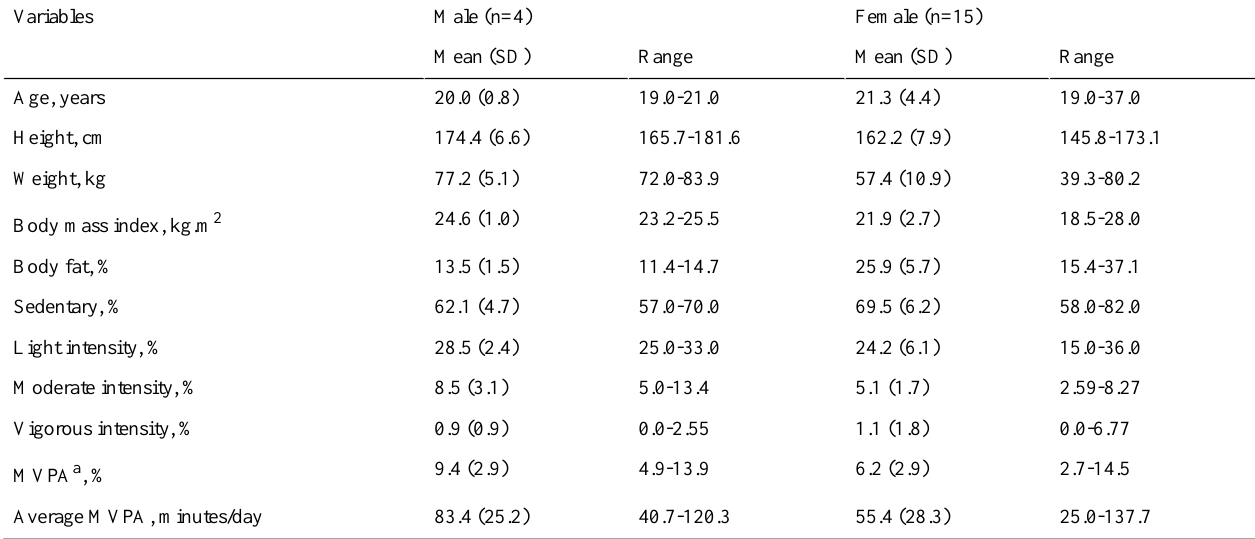
Table 1. Participant characteristics (N=19) and physical activity levels (determined from ActiGraph GT3X) averaged over 14